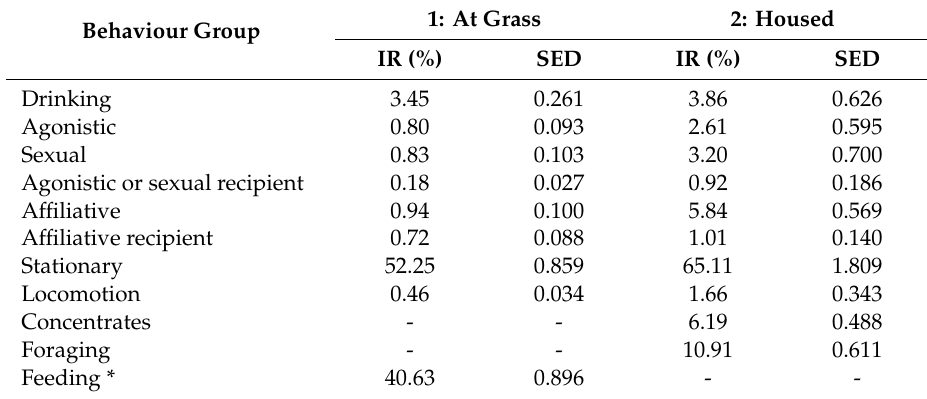
Table 3. Incidence rate (%) of behaviours during Study 1 and Study 2.